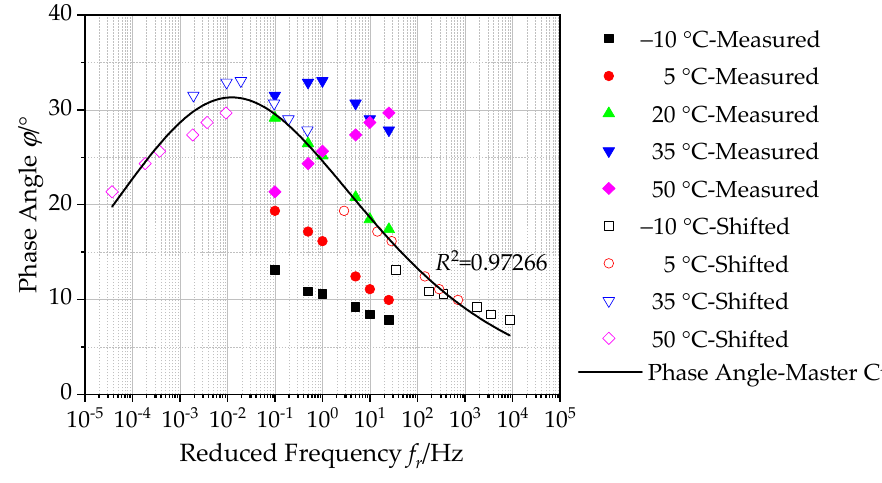
Figure 8. Master curve of phase angle (reference temperature = 20 °C).